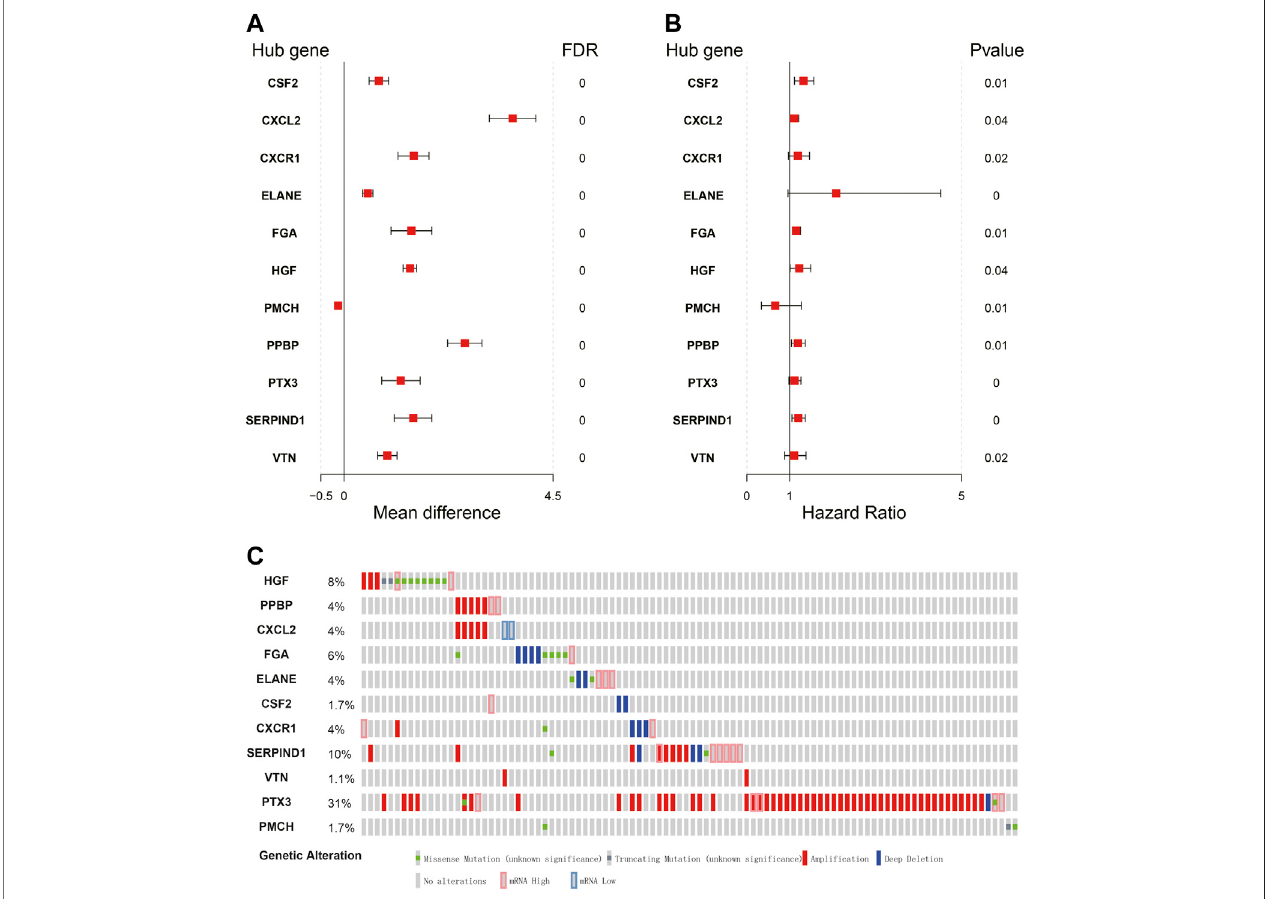
FIGURE5| Expressionpro fi lesandmutationlandscapeofhubimmune-relatedgenes. (A,B) Forestplotofthemeandifferenceshowinggenedifferencesbetween LUSCandnontumorsamples(leftpanel).Forestplotofhazardratiosshowingtheprognosticvaluesofgenes(rightpanel). (C) Thediagramre fl ectsthemutationtypeand frequency of risk genes.